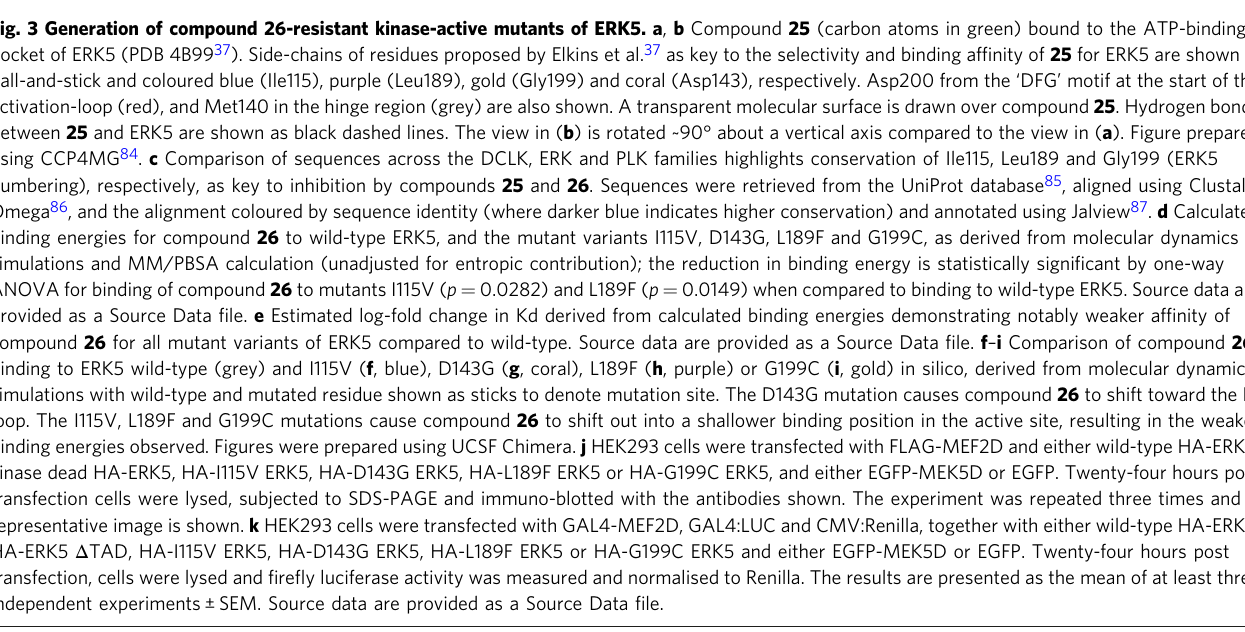
Fig. 3 Generation of compound 26-resistant kinase-active mutants of ERK5. a , b Compound 25 (carbon atoms in green) bound to the ATP-binding pocket of ERK5 (PDB 4B99 37 ). Side-chains of residues proposed by Elkins et al. 37 as key to the selectivity and binding af fi nity of 25 for ERK5 are shown in ball-and-stick and coloured blue (Ile115), purple (Leu189), gold (Gly199) and coral (Asp143), respectively. Asp200 from the ‘ DFG ’ motif at the start of the activation-loop (red), and Met140 in the hinge region (grey) are also shown. A transparent molecular surface is drawn over compound 25 . Hydrogen bonds between 25 and ERK5 are shown as black dashed lines. The view in ( b ) is rotated ~90° about a vertical axis compared to the view in ( a ). Figure prepared using CCP4MG 84 . c Comparison of sequences across the DCLK, ERK and PLK families highlights conservation of Ile115, Leu189 and Gly199 (ERK5 numbering), respectively, as key to inhibition by compounds 25 and 26 . Sequences were retrieved from the UniProt database 85 , aligned using Clustal Omega 86 , and the alignment coloured by sequence identity (where darker blue indicates higher conservation) and annotated using Jalview 87 . d Calculated binding energies for compound 26 to wild-type ERK5, and the mutant variants I115V, D143G, L189F and G199C, as derived from molecular dynamics simulations and MM/PBSA calculation (unadjusted for entropic contribution); the reduction in binding energy is statistically signi fi cant by one-way ANOVA for binding of compound 26 to mutants I115V ( p = 0.0282) and L189F ( p = 0.0149) when compared to binding to wild-type ERK5. Source data are provided as a Source Data fi le. e Estimated log-fold change in Kd derived from calculated binding energies demonstrating notably weaker af fi nity of compound 26 for all mutant variants of ERK5 compared to wild-type. Source data are provided as a Source Data fi le. f – i Comparison of compound 26 binding to ERK5 wild-type (grey) and I115V ( f , blue), D143G ( g , coral), L189F ( h , purple) or G199C ( i , gold) in silico, derived from molecular dynamics simulations with wild-type and mutated residue shown as sticks to denote mutation site. The D143G mutation causes compound 26 to shift toward the P- loop. The I115V, L189F and G199C mutations cause compound 26 to shift out into a shallower binding position in the active site, resulting in the weaker binding energies observed. Figures were prepared using UCSF Chimera. j HEK293 cells were transfected with FLAG-MEF2D and either wild-type HA-ERK5, kinase dead HA-ERK5, HA-I115V ERK5, HA-D143G ERK5, HA-L189F ERK5 or HA-G199C ERK5, and either EGFP-MEK5D or EGFP. Twenty-four hours post transfection cells were lysed, subjected to SDS-PAGE and immuno-blotted with the antibodies shown. The experiment was repeated three times and a representative image is shown. k HEK293 cells were transfected with GAL4-MEF2D, GAL4:LUC and CMV:Renilla, together with either wild-type HA-ERK5, HA-ERK5 Δ TAD, HA-I115V ERK5, HA-D143G ERK5, HA-L189F ERK5 or HA-G199C ERK5 and either EGFP-MEK5D or EGFP. Twenty-four hours